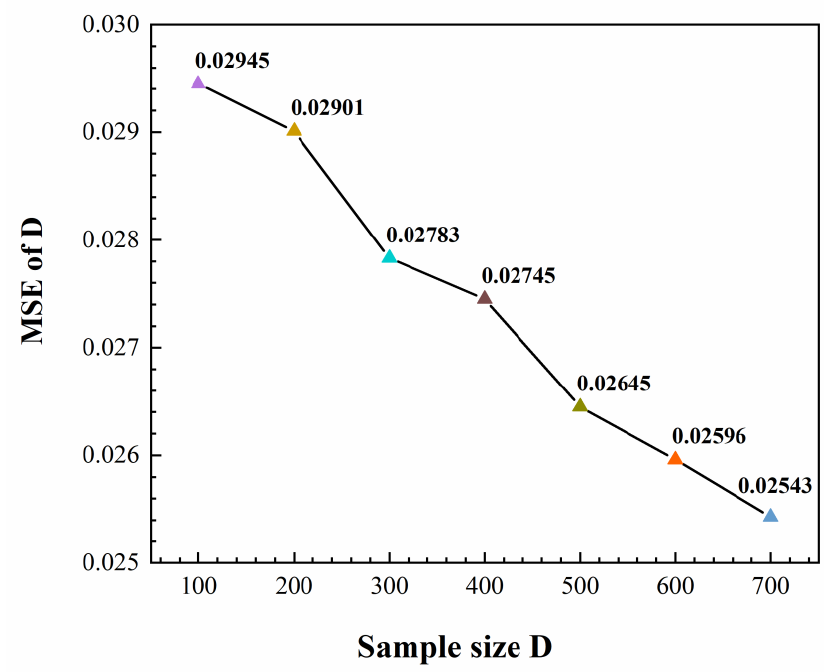
Figure 13. The influence of the sample size D on prediction